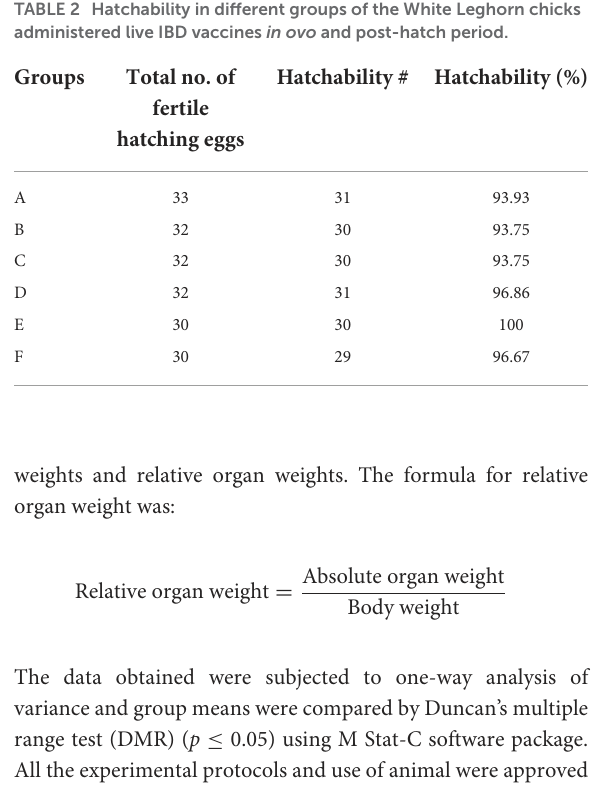
TABLE 1 Experimental design for chicks. TABLE 2 Hatchability in different groups of the White Leghorn chicks